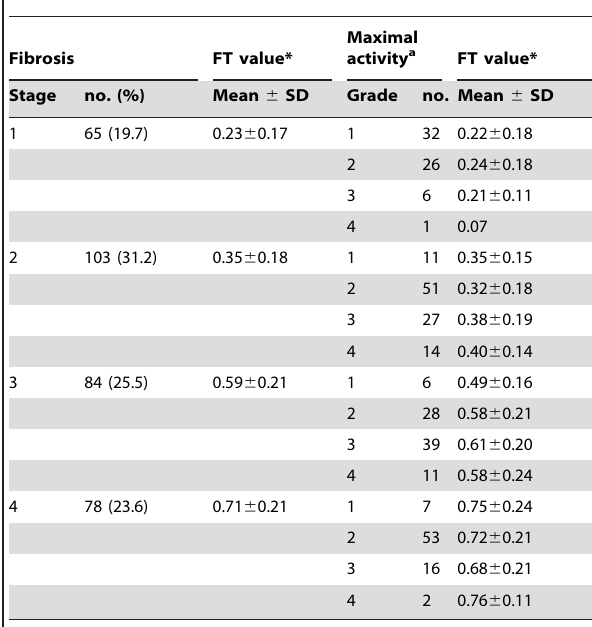
Table 2. Liver histology and corresponding FT values